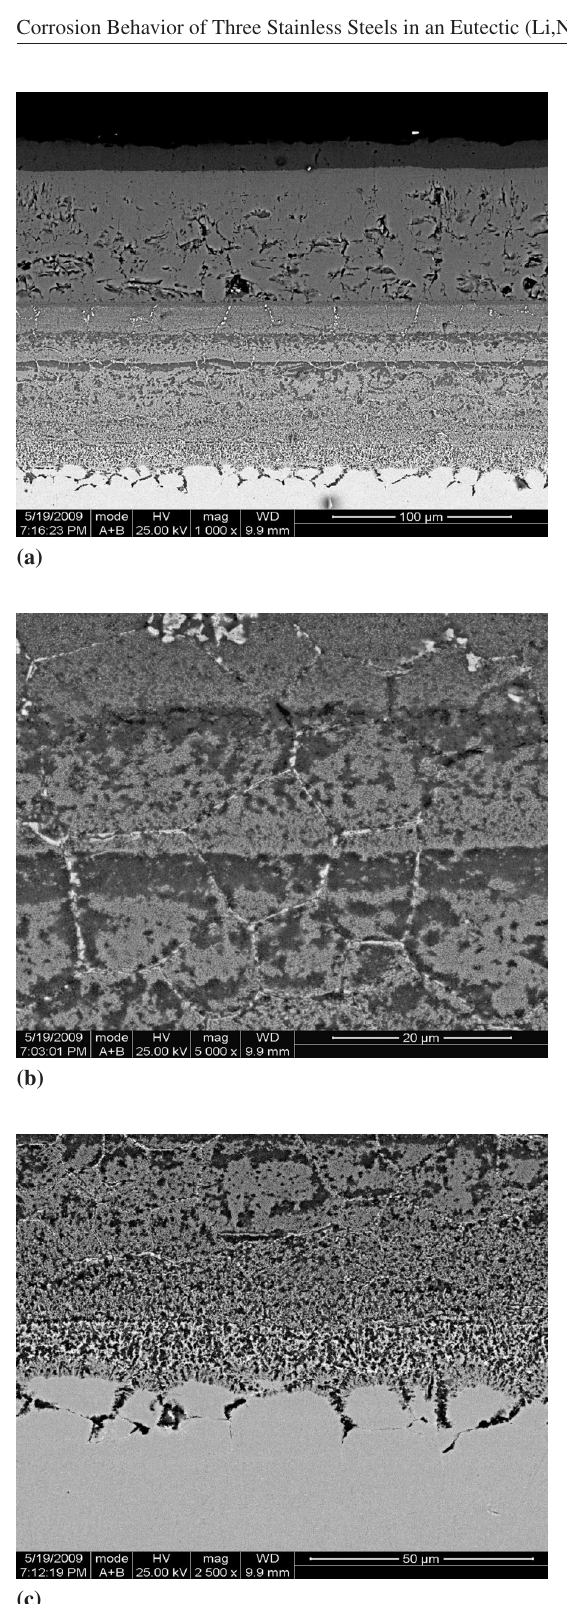
Figure 5. Cross-sectional morphologies of 316 SS corroded at 973 K in (Li,Na,K) 2 CO 3 for 500 h. (a) gerneral view; (b) and (c) the amplified views of the inner layer of (a).